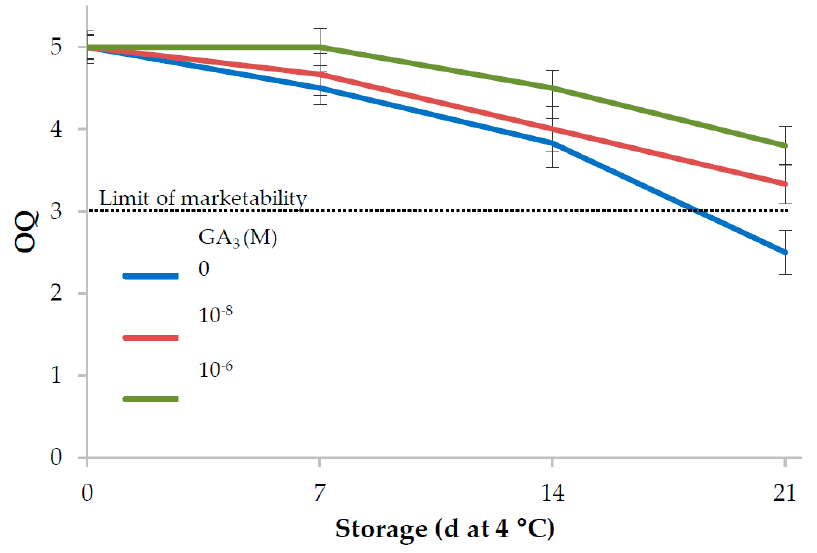
Figure 1. Influence of GA 3 treatments and storage at 4 °C on overall quality of minimally processed lettuce (5: excellent or having a fresh appearance; 3: average—limit of marketability; 1: unmarketable).